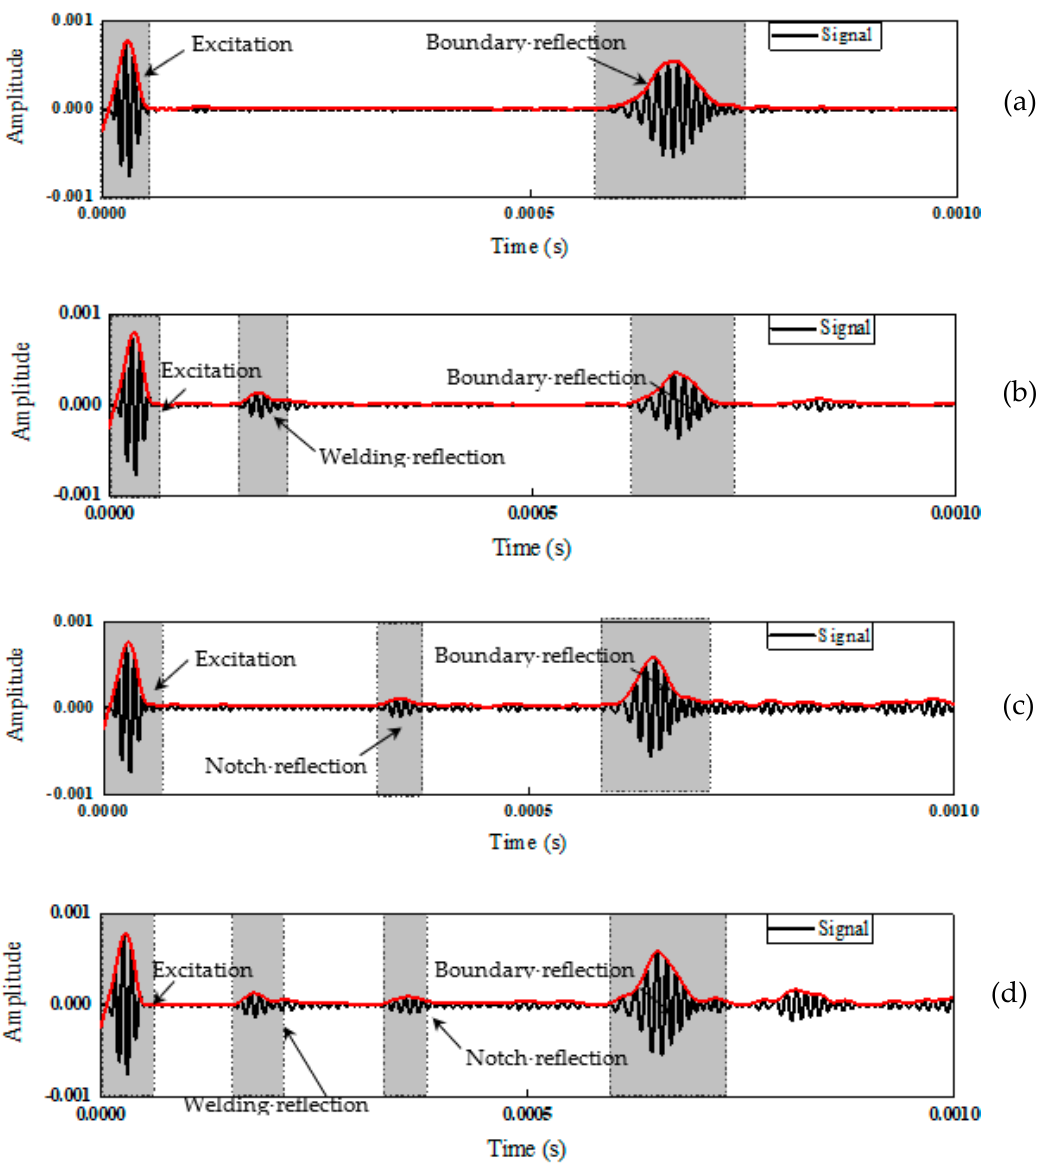
Figure 7. Signal characteristics of the pipes under varying cases: ( a ) intact pipe; ( b ) pipe with a weld; ( c ) pipe with a crack; ( d ) pipe with crack and weld.